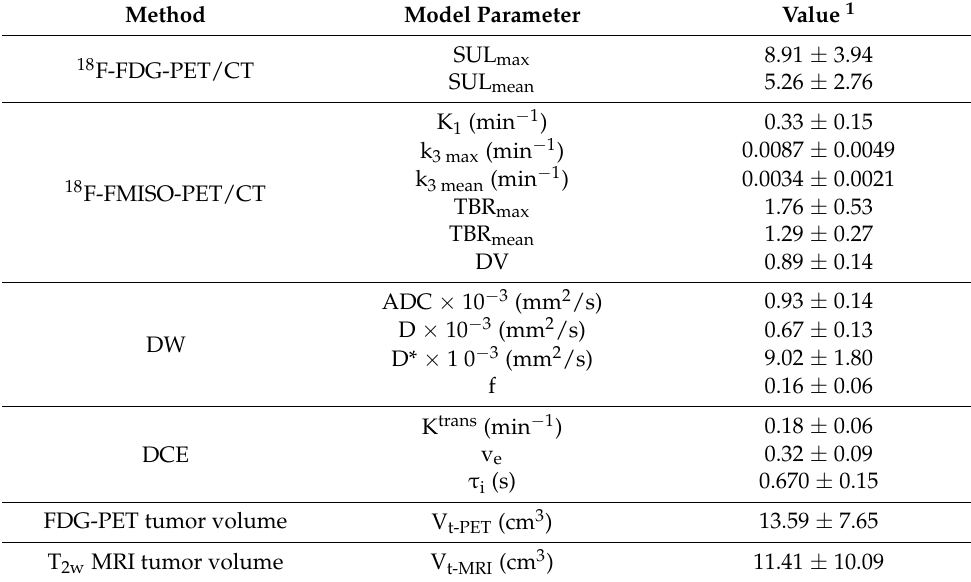
Table 1. Summary of multimodality imaging derived quantitative imaging metrics values. Method Model Parameter Value 1 SUL 18 F-FDG-PET/CT